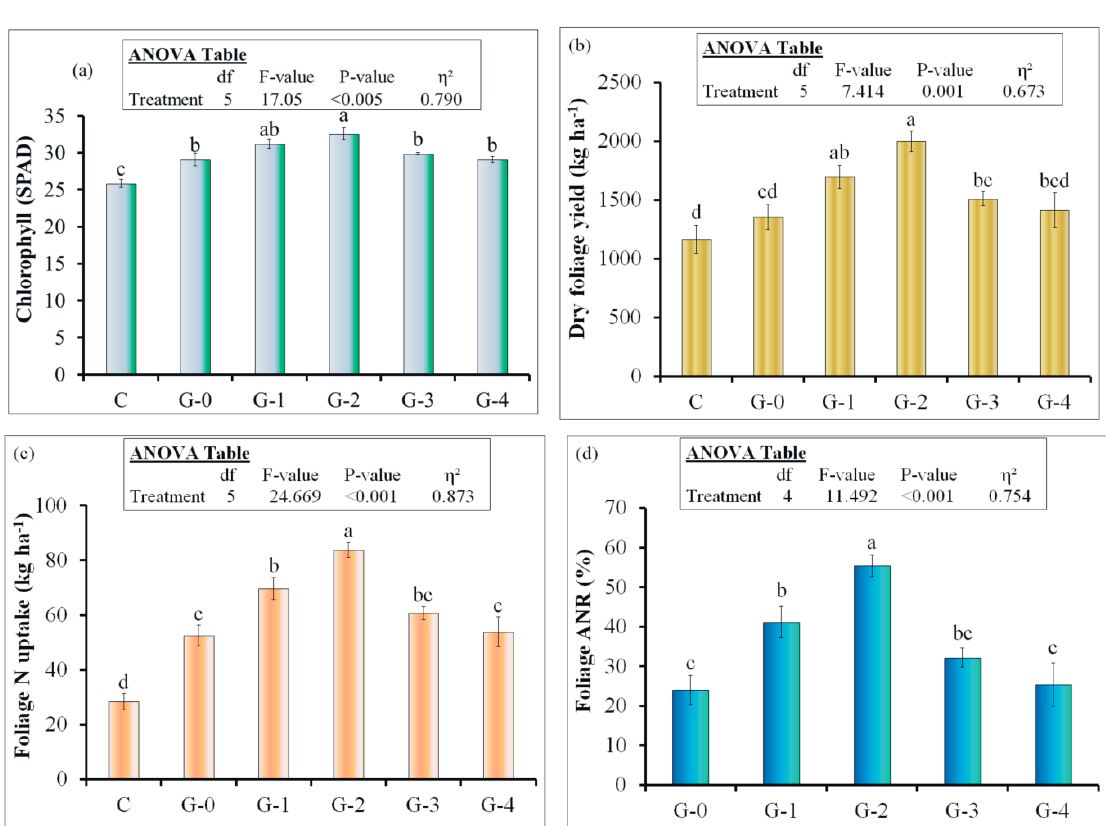
Figure 6. Spinach ( a ) chlorophyll content, ( b ) dry foliage yield, ( c ) N uptake and ( d ) apparent N recovery (ANR) from coated and uncoated urea treatments. Abbreviations of fertilizer treatments can be seen in the caption of Figure 1 and C stands for control (untreated). The small letters on the bars indicate the difference among treatments at 5% probability level. Error bars show the standard error of the mean (n = 4). Insets in the figures represent outcomes of the analysis of variance (ANOVA).